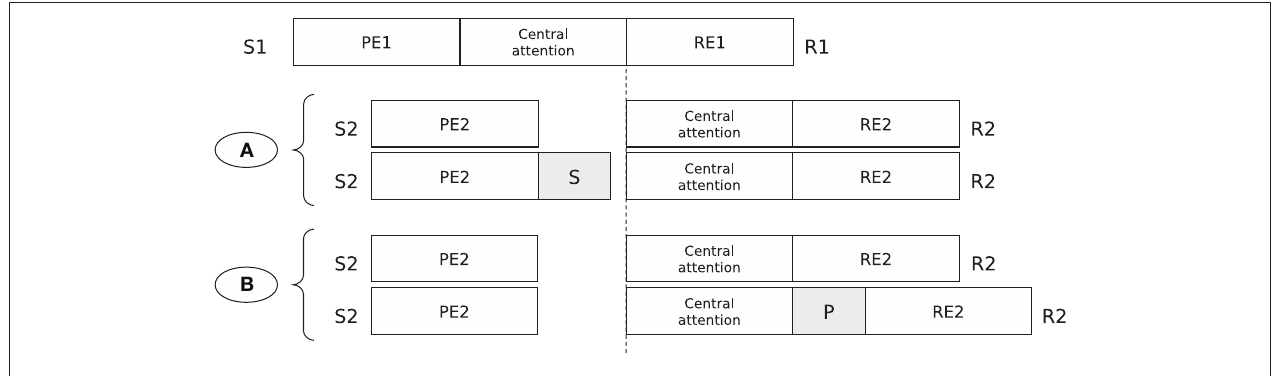
Figure 1 | (A) Gant diagrams illustrating the account of the under additivity between SOA and semantic effects (shaded box labeled S) proposed by Dell’Acqua et al. (2007a). (B) Gant diagrams illustrating the account of the additivity between SOA and phonological effects (shaded box labeled P) and the under additivity